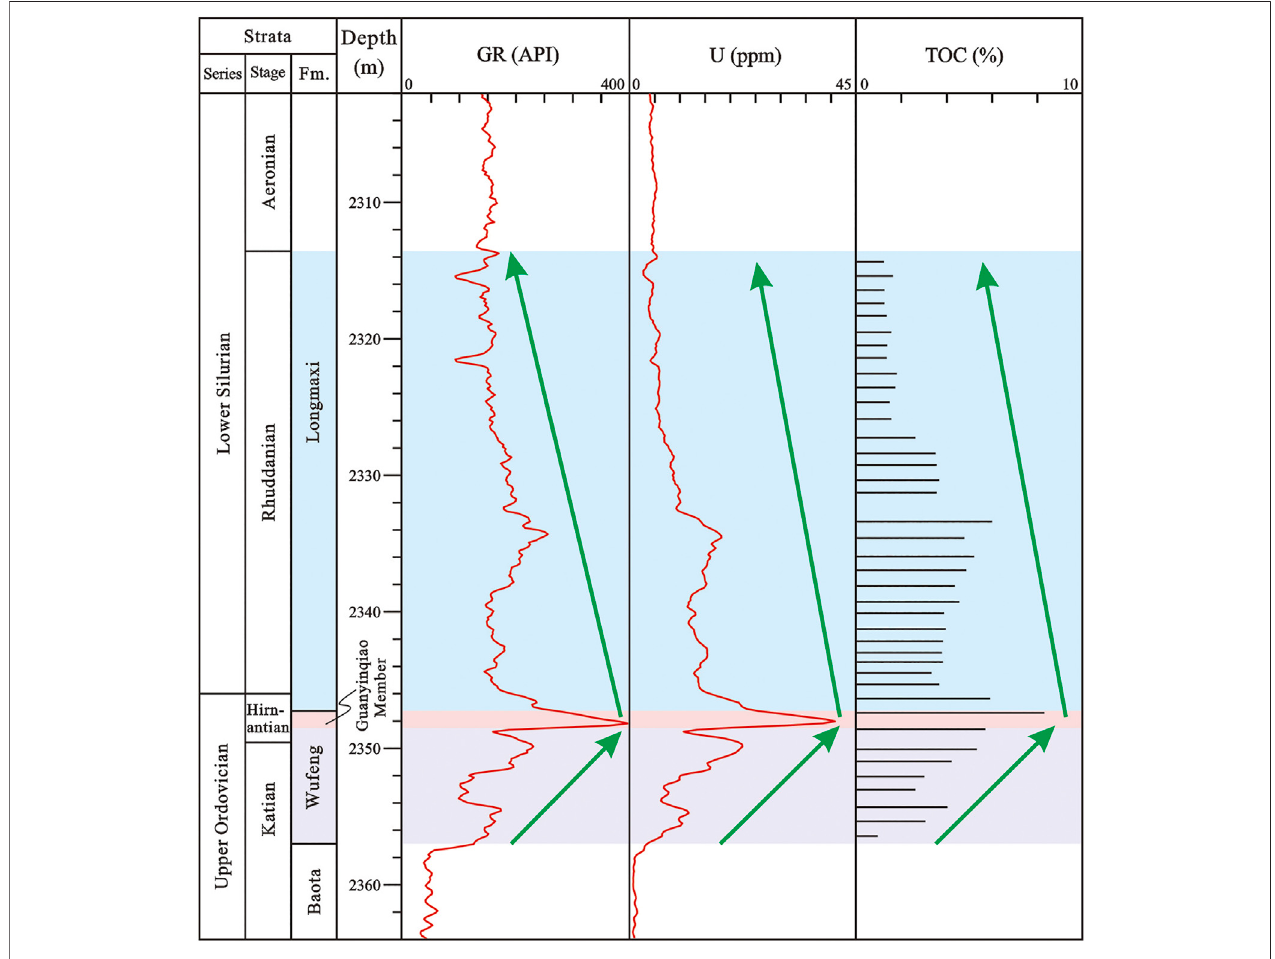
FIGURE 5 | TOC and well log characteristics of the Wufeng Formation and the lower Longmaxi Formation in well N211 in the Upper Yangtze Region.